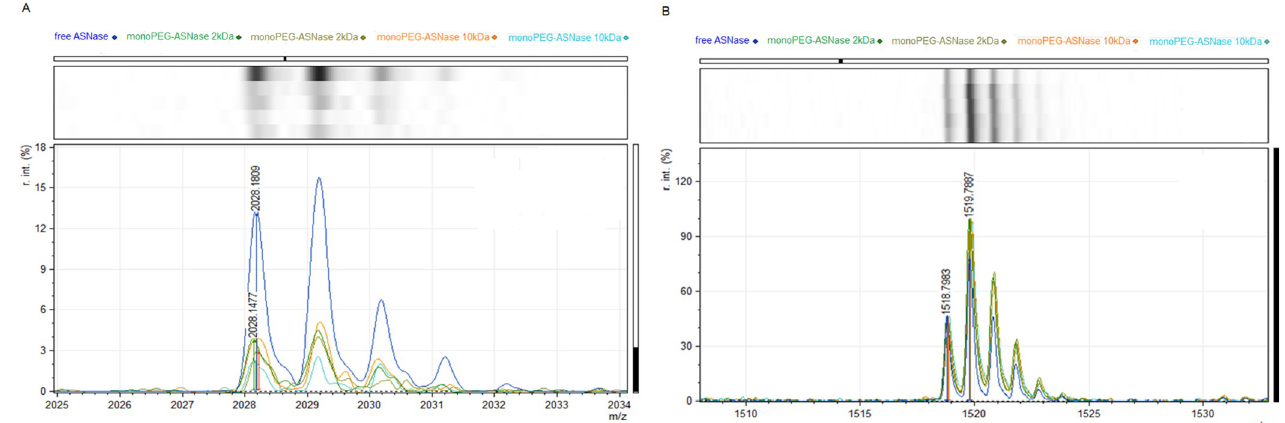
Fig 4. MALDI-TOF of free ASNAse and monoPEG-ASNase (with 2kDa and 10kDa PEG). (A) N-terminal peptide LPNITILATGGTIAGGGDSATK.(S) at m/z 2028.1809 and (B) lysine peptide SVNYGPLGYIHNGK.(I) , at m/z 1518.7. Samples were acquired in duplicate. ASNase; blue line–monoPEG-ASNase 2kDa; light and dark green line—monoPEG-ASNase 10kDa; light blue line and orange.